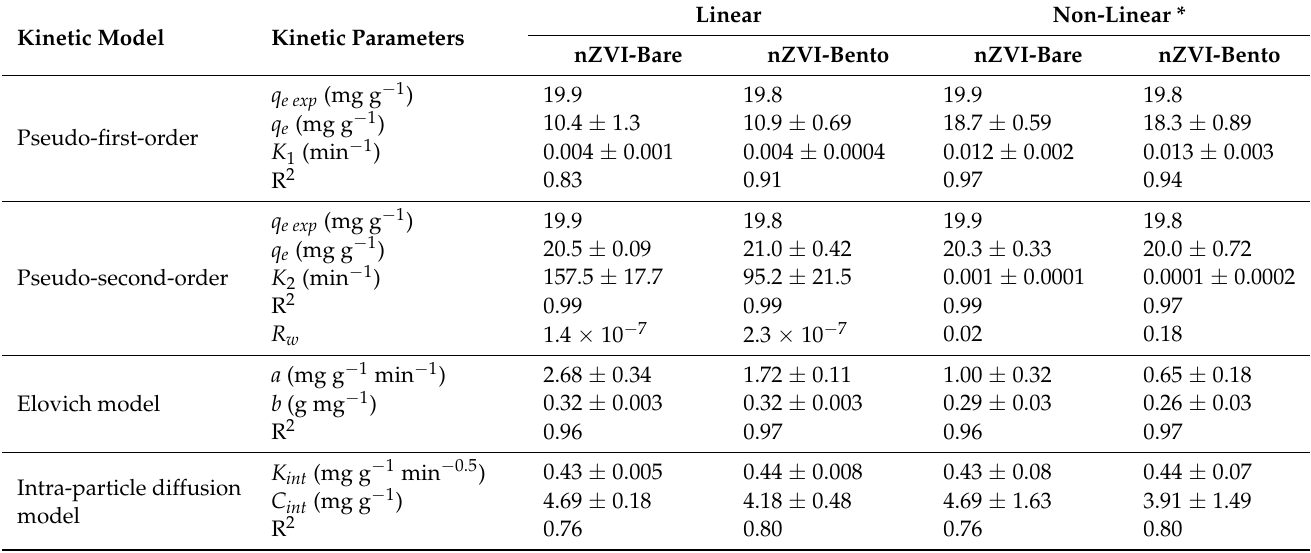
Table 1. Kinetic model parameters of As (V) sorption on ZVI